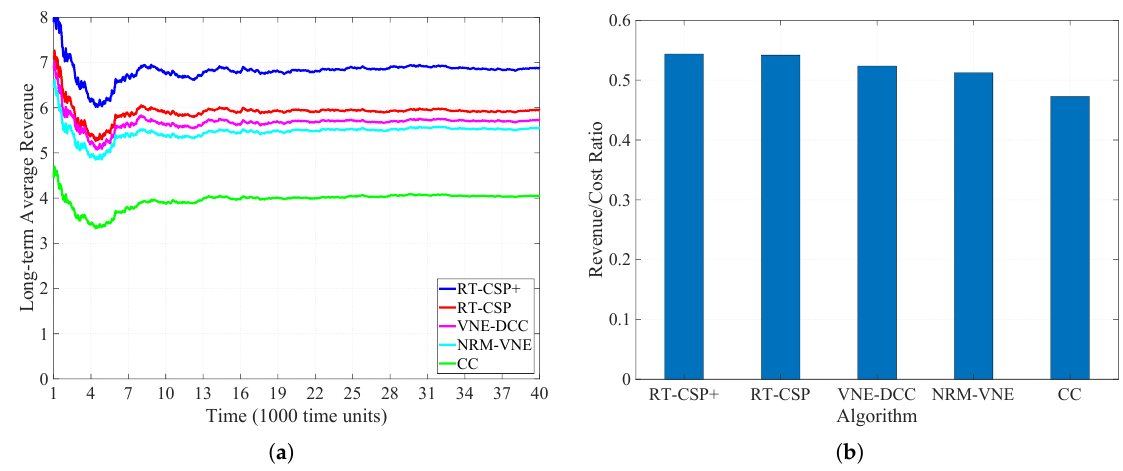
Figure 3. ( a ) Long-term average slice provisioning revenue; and ( b ) slice provisioning revenue-to-cost